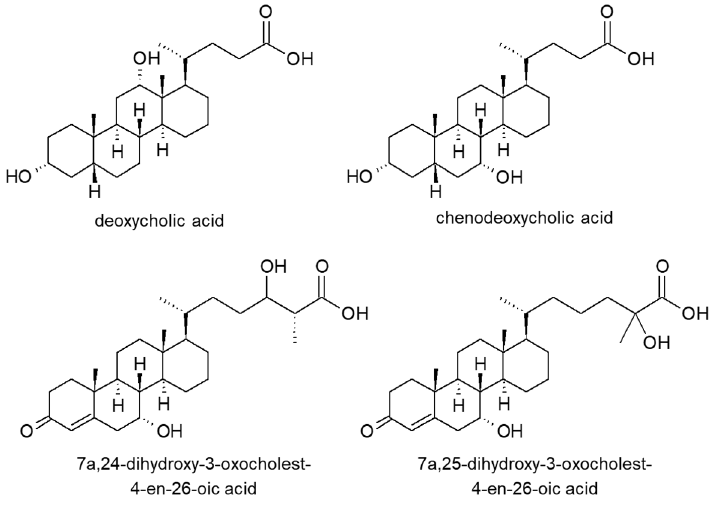
Figure 15. Chemical structures of bile acids and their metabolites.